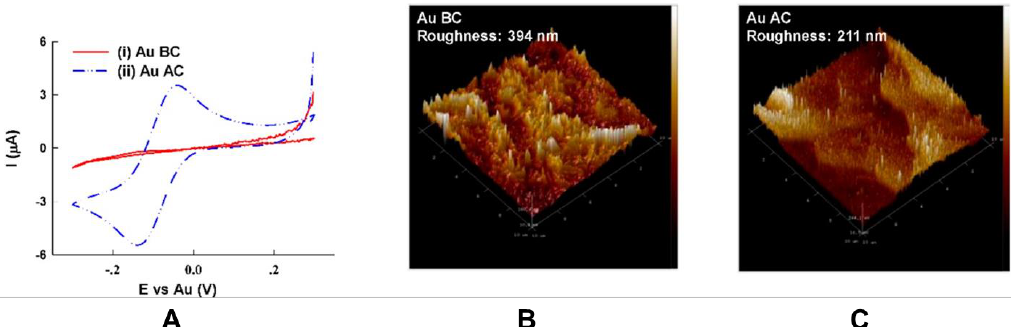
Figure 3. Comparison between Au-plated PCB electrode before and after cleaning: ( A ) cyclic voltammograms obtained from Au-Plated PCB electrodes in a PBS solution containing 4 mM K 3 Fe(CN) 6 before cleaning (i) and after cleaning (ii); ( B ) atomic force microscopy of Au-plated PCB electrodes obtained before cleaning, and ( C ) after cleaning. The size of the atomic force microscopy (AFM) micrographs was not specified in the original figure. Reproduced from [13] , Creative